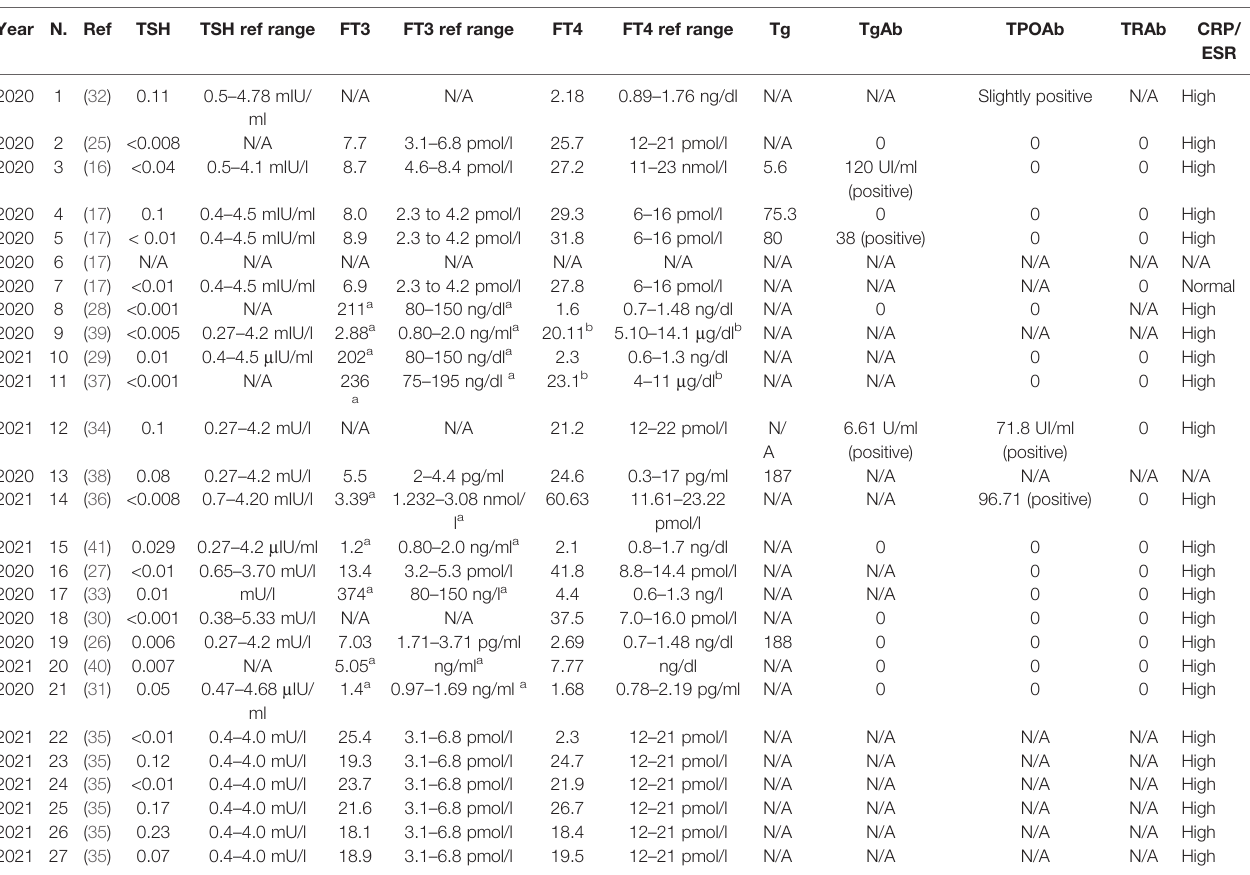
TABLE 2 | Biochemical evaluation of thyroid function parameters, thyroglobulin, thyroid autoantibodies, and in fl ammatory markers in the 27 included patients. Year N. Ref